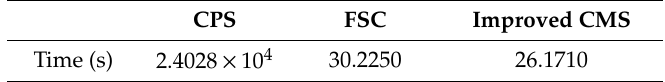
Table 7. Computing consumption of the three algorithms in experimental